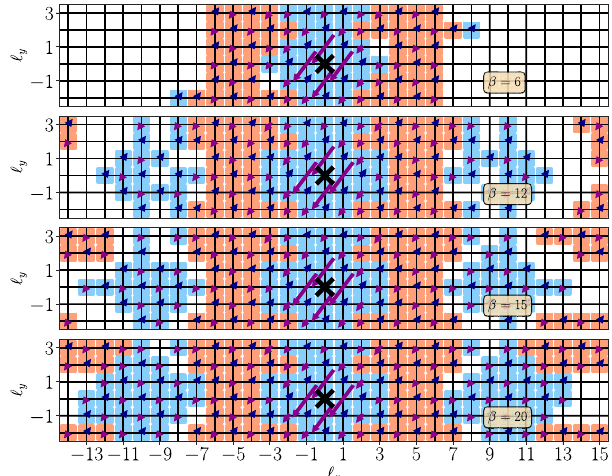
FIG. 8. Evolution of the spin correlation function C s ð l x ; l y Þ as T is lowered, at δ ¼ 1 = 5 , on a 30 × 6 lattice with U ¼ 6 . PBC is used in both directions. AFM regions are observed, and the results in this finite system do not distinguish short- versus long- range order.